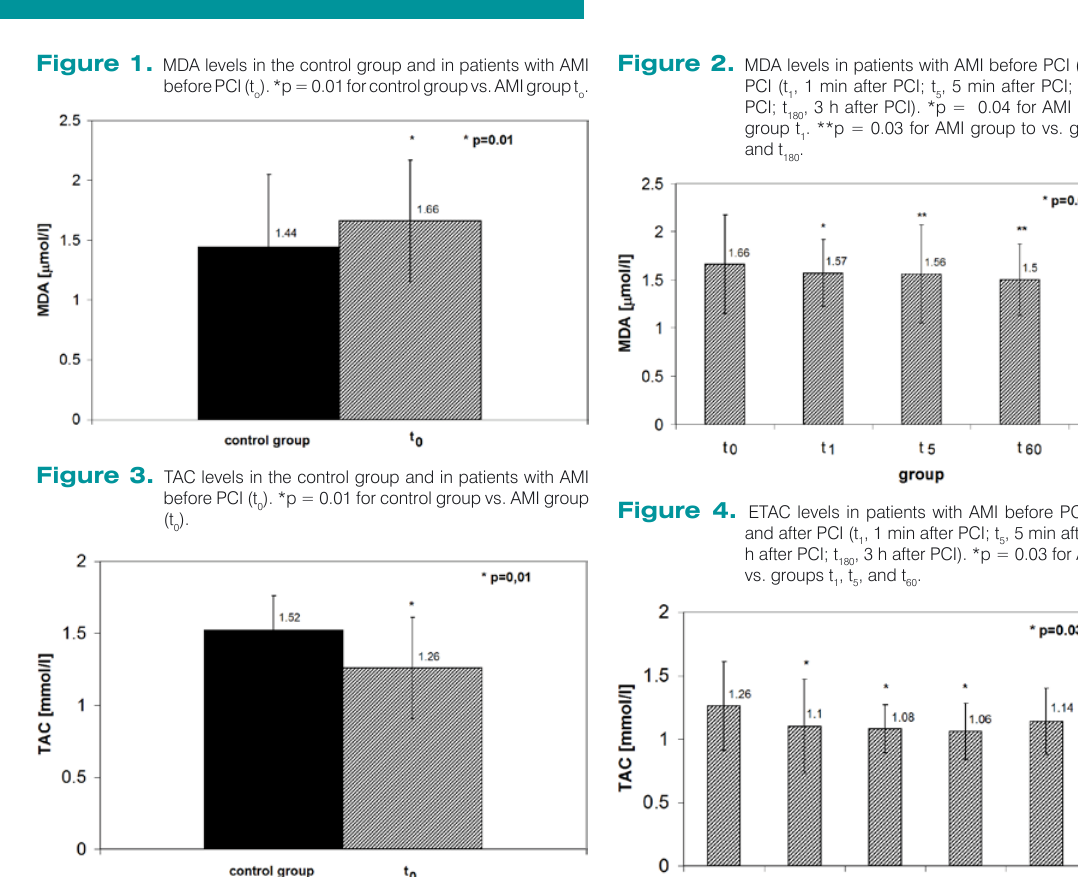
Figure 2. MDA levels in patients with AMI before PCI (t . o